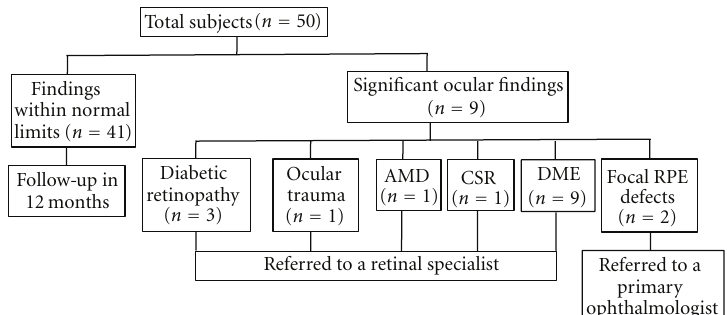
Figure 1: Flow chart of imaging results and referral patterns. Abbreviations: DME: diabetic macular edema; AMD: age-related macular degeneration; CSR: central serous retinopathy; RPE: retinal pigment epithelium.